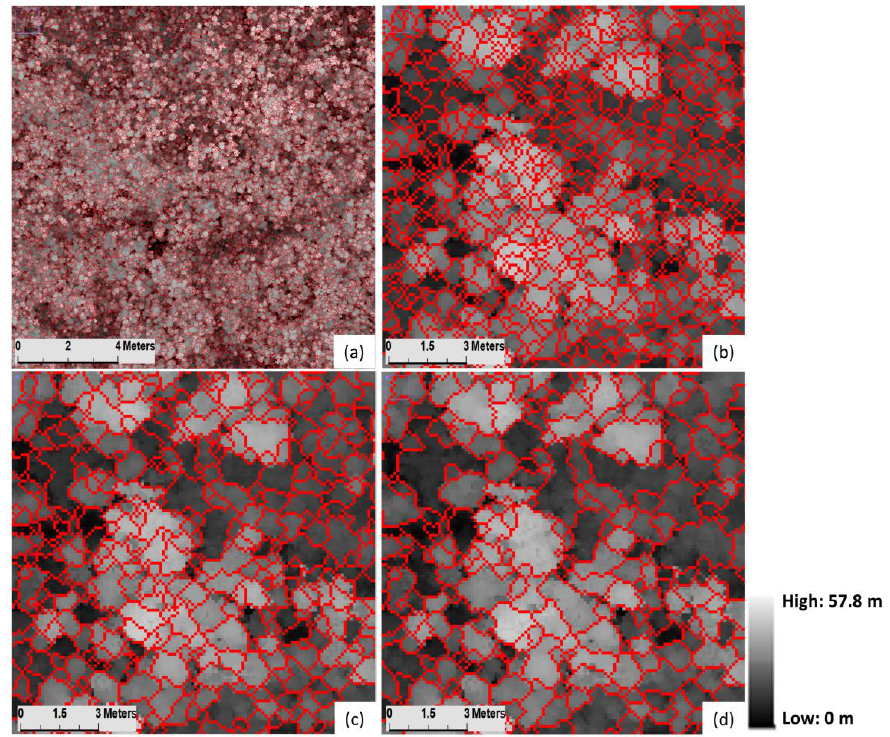
Figure 6. The crown segmentation map of the PFR site: ( a ) crown segmentation map over 100 ha and the segmentation at ( b ) small, ( c ) medium and ( d ) large tree crown levels with the corresponding filtered images in the